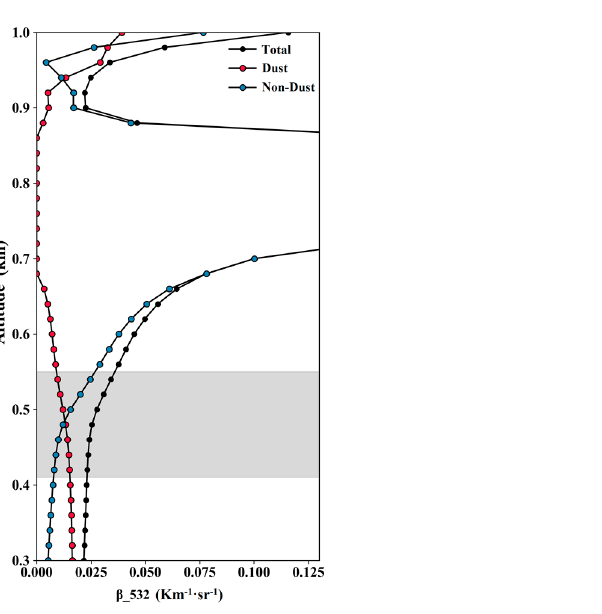
Figure 6. MPL-measured mean vertical 532 nm 𝛽 profile (black dots) on 5 February 2019 (Case I) from 1050 to 1150 UTC, the non-dust fine-mode 532 nm 𝛽 profile (blue dots) extracted from the mean profile, and the dust coarse-mode 532 nm 𝛽 profile (red dots) extracted from the mean profile.